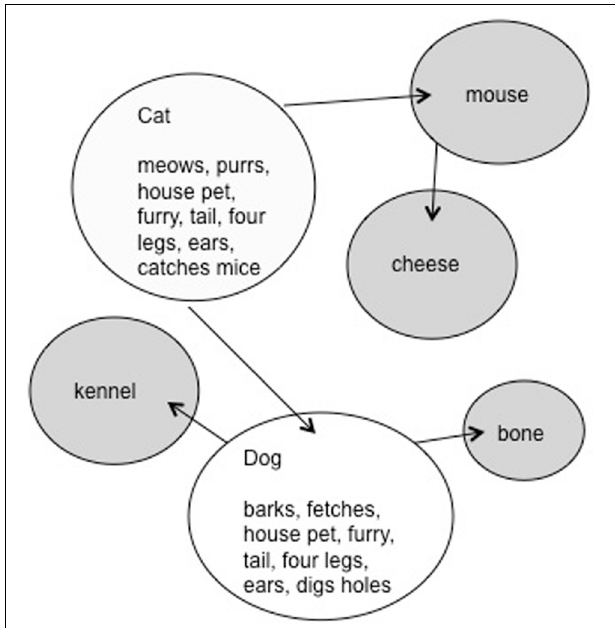
FIGURE 2 | The activation created by CAT and DOG in the LH semantic system during the same hypothetical experimental trial. The circles in white represent the activation of the bound features for each gestalt representation. The arrows indicate the associative links between concepts. The gray circles are concepts through which activation has spread via associative